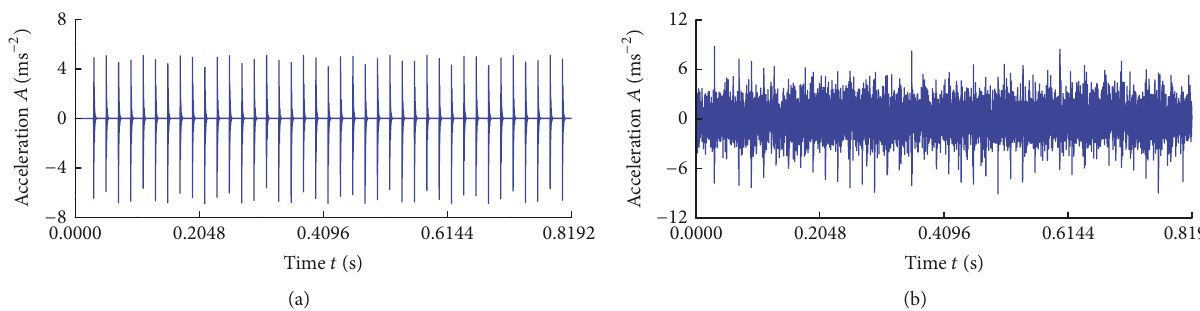
Figure 2: Simulation signals: (a) the original signals with periodic impulses and (b) the signals with added white noise (SNR = −7 dB).